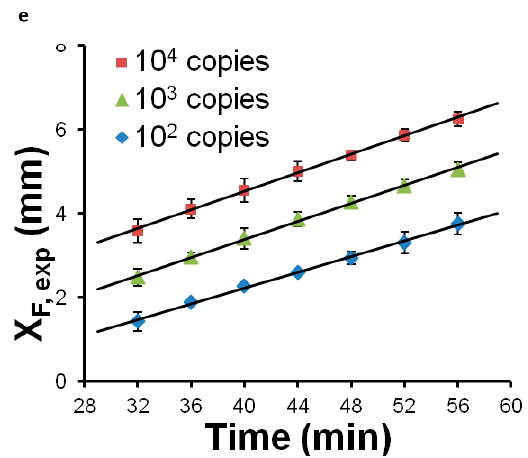
Figure 8. Nuclemeter for Quantifying Nucleic Acids: Nuclemeter chip features an array of reaction-diffusion microconduits for isothermal amplification. The chamber and conduits are filled with LAMP amplification mix including an intercalating DNA green dye, primers, and hydroxypropyl-methyl-cellulose as a low-viscosity sieving matrix to reduce diffusivity. The target nucleic acid template is introduced at the column’s inlet. As isothermal amplification proceeds, the amplification products diffuse down the channel, such that the distance of the reaction front from the chamber X F can be correlated with time and template number (copies). At any given time, the length of the fluorescent column can be calibrated against a ruler scale imprinted on the chip. ( a ) Cross-section of reaction-diffusion channel; ( b ) schematic of reaction front, ( c ) photo of nuclemeter chip; ( d ) Photos of reaction diffusion conduits at 0, 16, 32 and 56 min, and ( e ) Diffusion front X F position (mm) as a function of time for three different sample (initial) template concentrations: 10 4 , 10 5 and 10 6 copies. From [115].